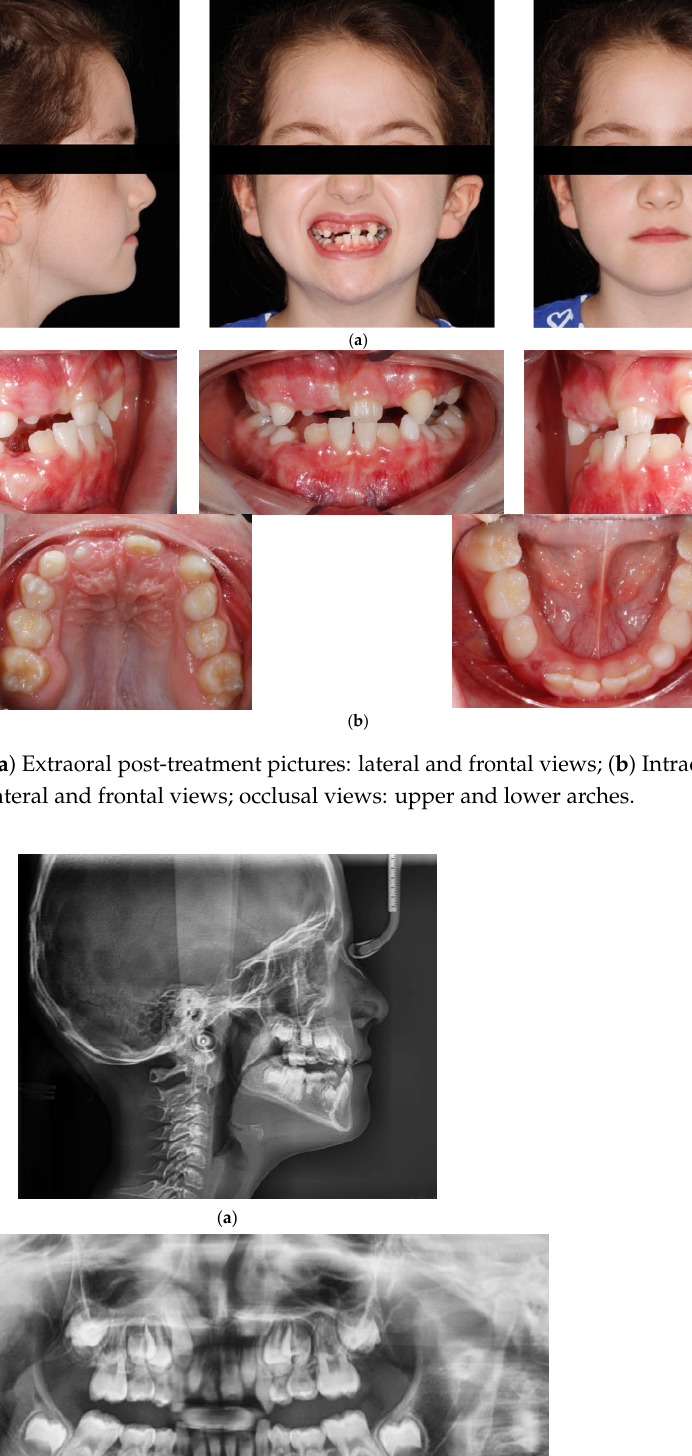
Figure 7. Post-treatment radiographic records: ( a ) lateral cephalogram; ( b ) orthopantomogram.